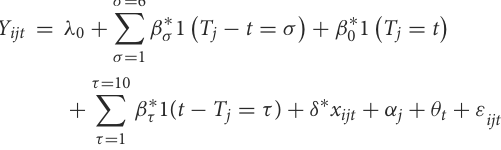
variables in control group and intervention group were parallel before health insurance integration by controlling all independent variables (with the last period before health insurance